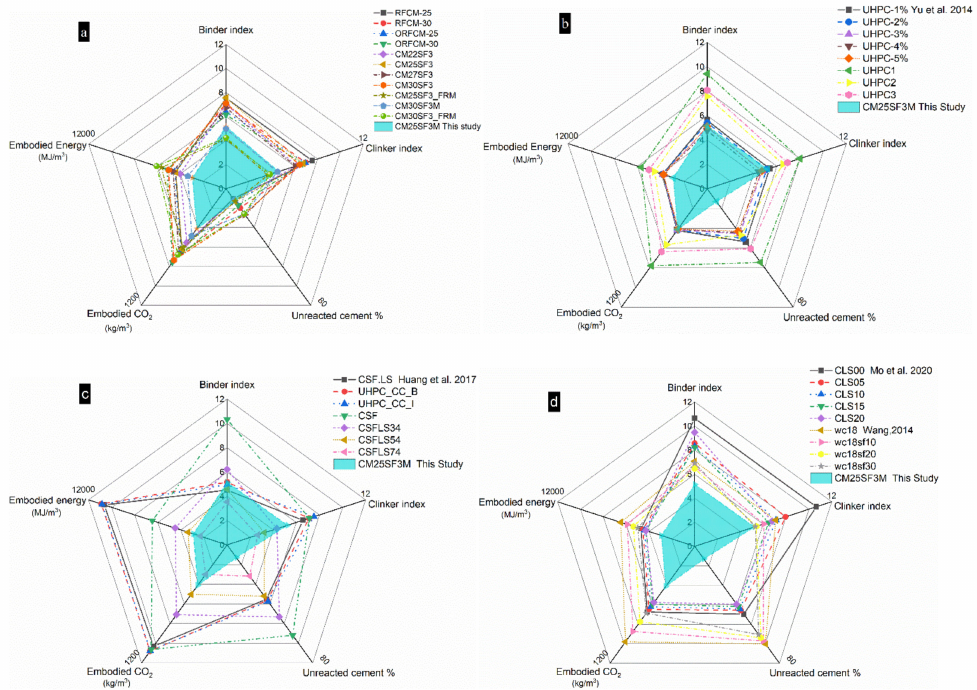
Figure 17. Comprehensive evaluation and comparison of the environmental impact between reverse filling system ( a ) and UHPC/UHFRPC ( b – d